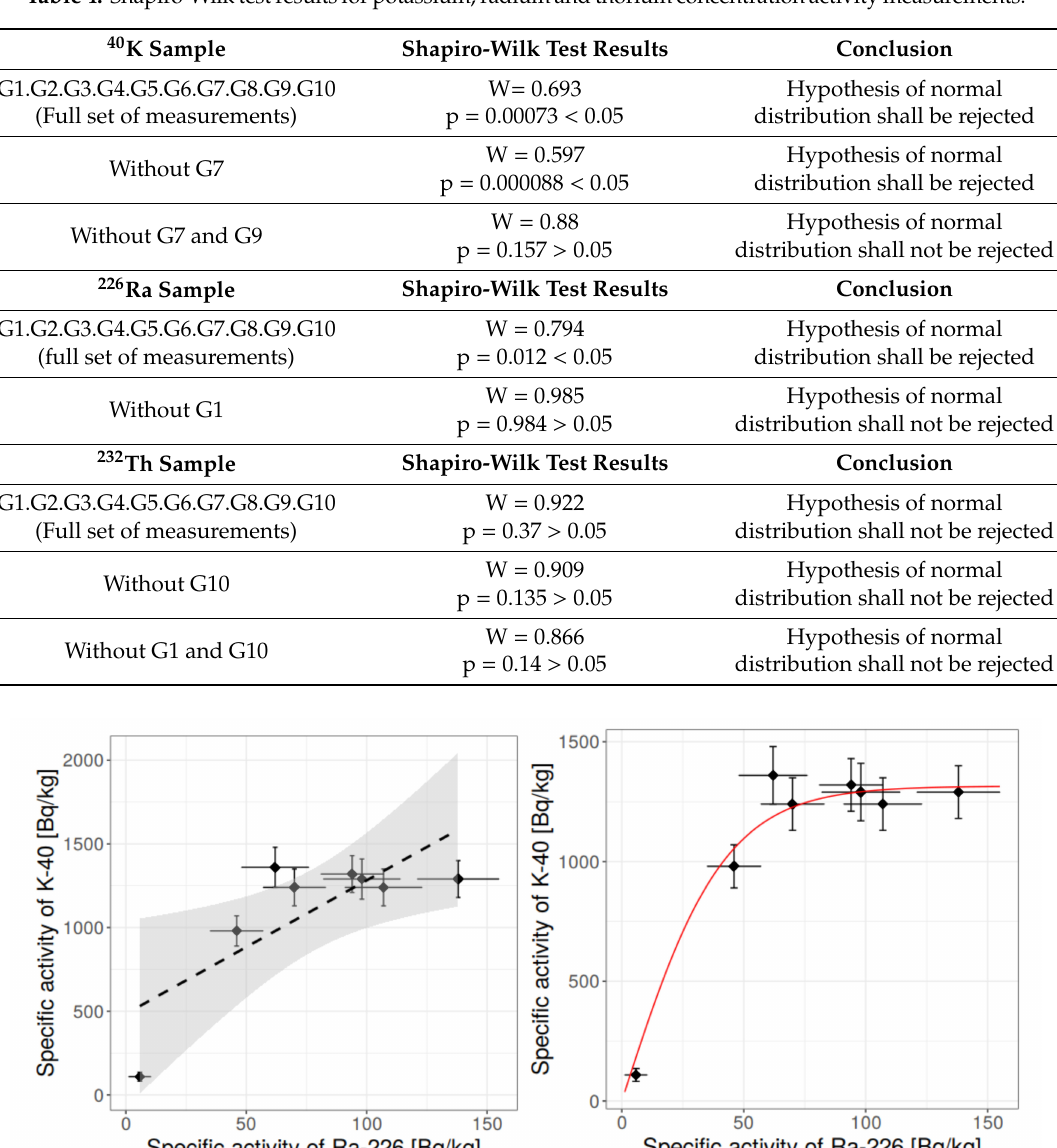
Table 4. Shapiro-Wilk test results for potassium, radium and thorium concentration activity measurements.